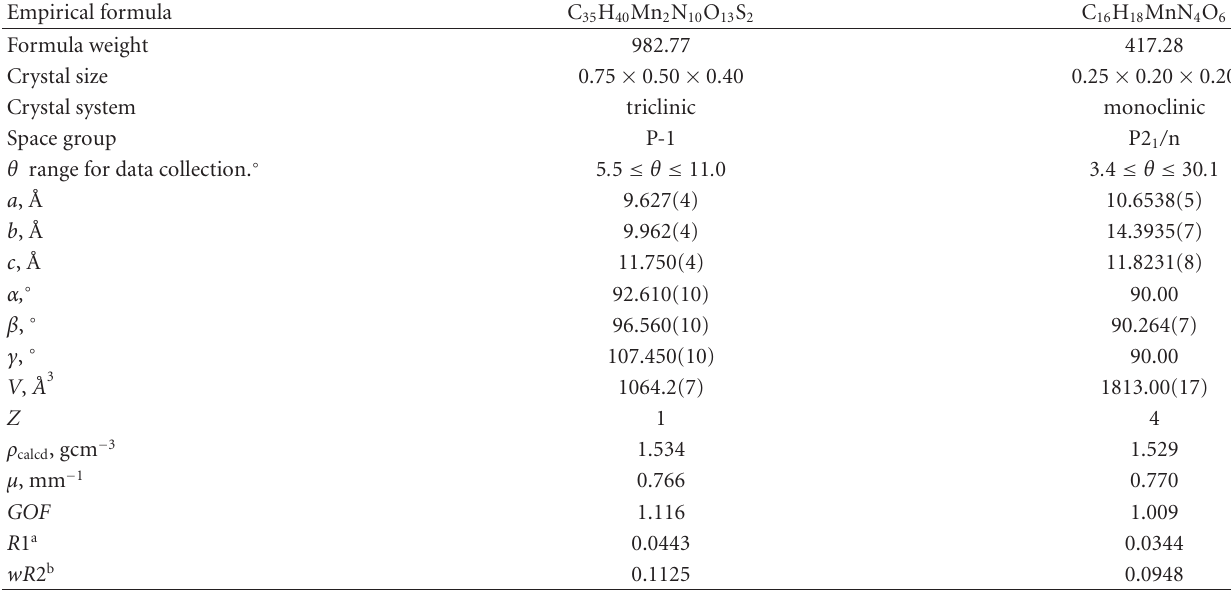
Table 1: Crystal data and structure refinement for 1 · (py)C(Me)NOH and 2.